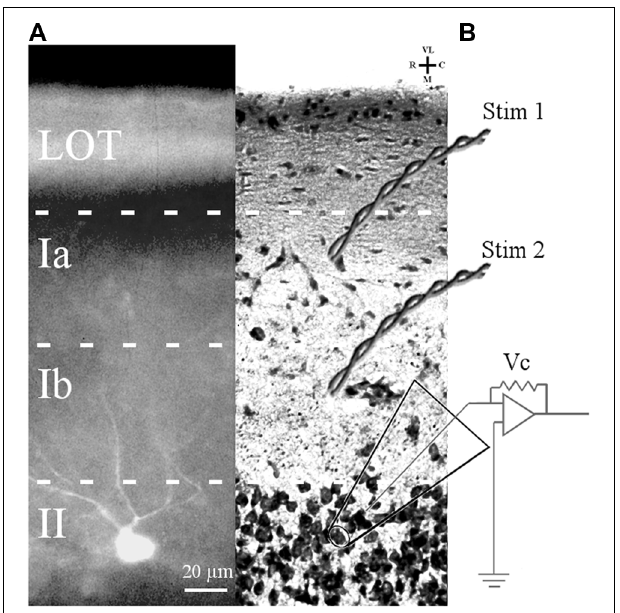
FIGURE 1 | Slice preparation ofAPC and arrangement of stimulation and recording electrodes. (A) A Lucifer yellow-filled cell in APC slice is shown.The soma is located in layer II and primary dendrites (only partially in the focal plane) ascend through layer I. (B) Cresyl violet-stained APC section showing position of bipolar electrodes to stimulate LOT fibers (Stim 1) and ASSN fibers (Stim 2). Patch clamp recordings were obtained in the whole cell configuration from somata of layer II principal cells visually identified under DIC